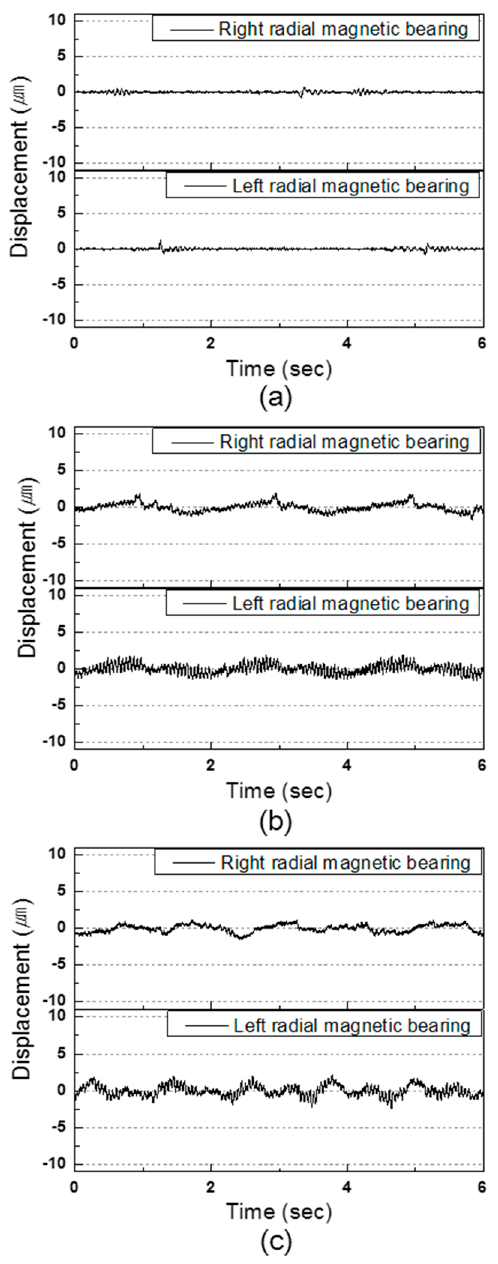
Figure 8. Vibration due to the load during the magnetic levitation of the roller: ( a ) stop condition (0 rev / min, 0 N); ( b ) rotation condition (30 rev / min, 0 N); and ( c ) rotation condition under a force load (30 rev / min, 300 N).